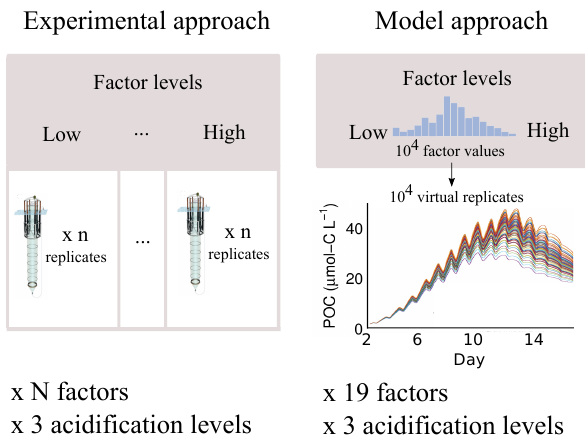
Figure 8. The exploration of the sources of variability in an ex- periment with a multi-way repeated measures ANOVA design with 3 acidification levels requires a multi-factorial high-dimensional setup (left panel). Alternately, we numerically simulate the biomass dynamics with 10 4 virtual replicates, each one with a different nor- mally distributed factor value (right panel). Uncertainty propagation relates the dispersion of the factor values with the dispersion of the POC trajectories. As an example, we plot results of POC variability in 50 virtual replicates of PeECE III at low acidification with un- certainty in initial nutrient concentration. Mesocosm drawing from Scheinin et al.